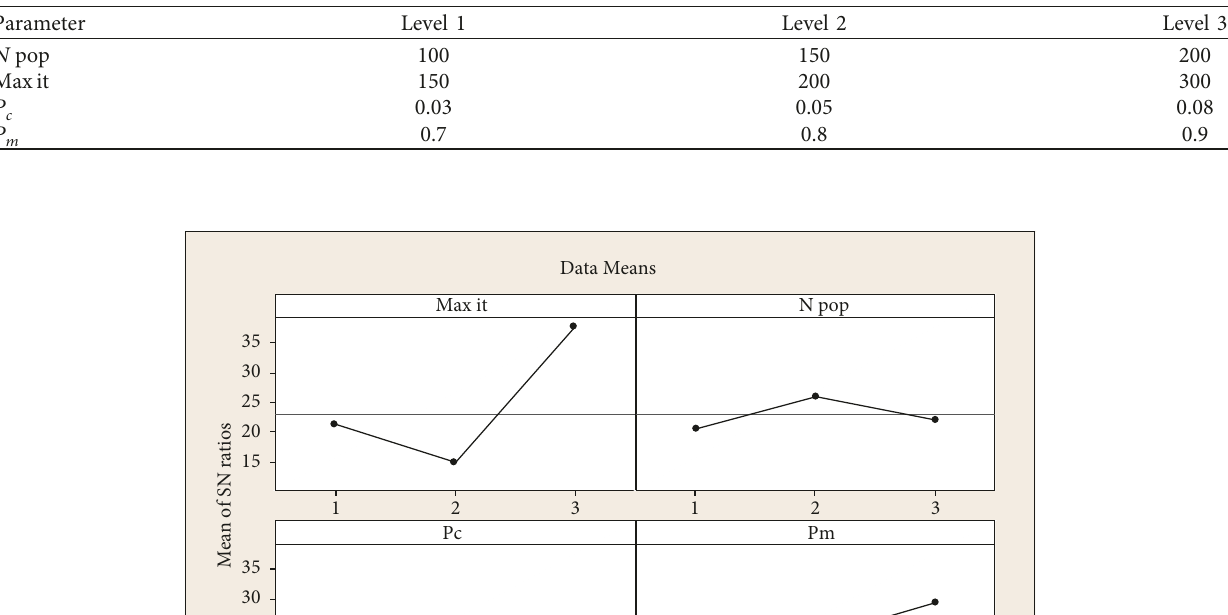
Table 3: Parametric adjustment of meta-heuristic algorithms by the Taguchi method.